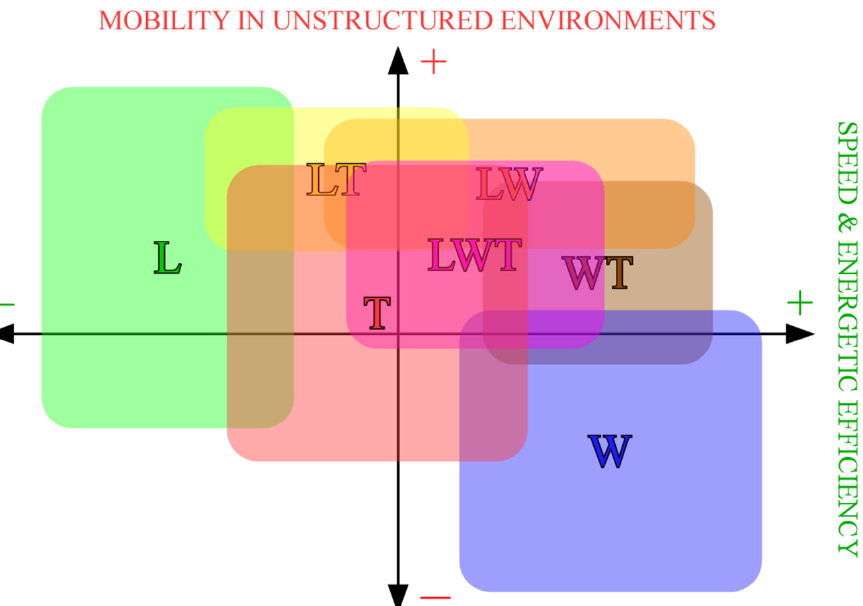
Figure 1. Mobility in unstructured environments vs. speed and energetic efficiency of the possible hybrid locomotion systems (Adapted with permission from [13], copyright 2012, L. Bruzzone and G. Quaglia).